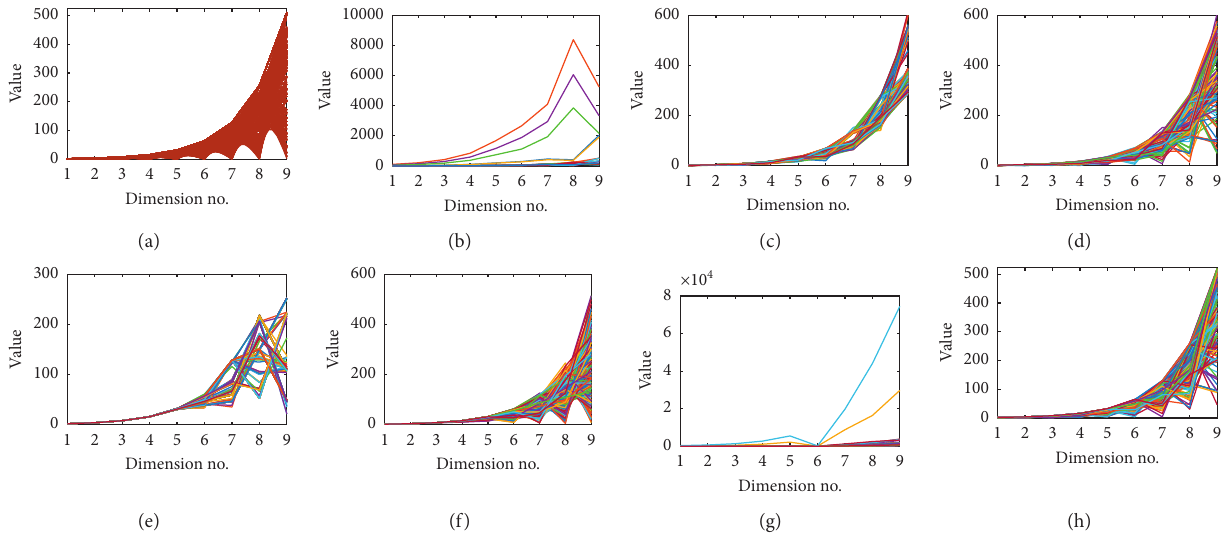
Figure 2: For 9-objective MaF4, its true PF and output populations of seven algorithms in parallel coordinate: (a) true PF of MaF4; (b) RVEA on MaF4; (c) NSGA-III on MaF4; (d) VaEA on MaF4; (e) MOEA/DD on MaF4; (f) SPEA2+SDE on MaF4; (g) MOEA/D-AM2M on MaF4; (h) ASES on